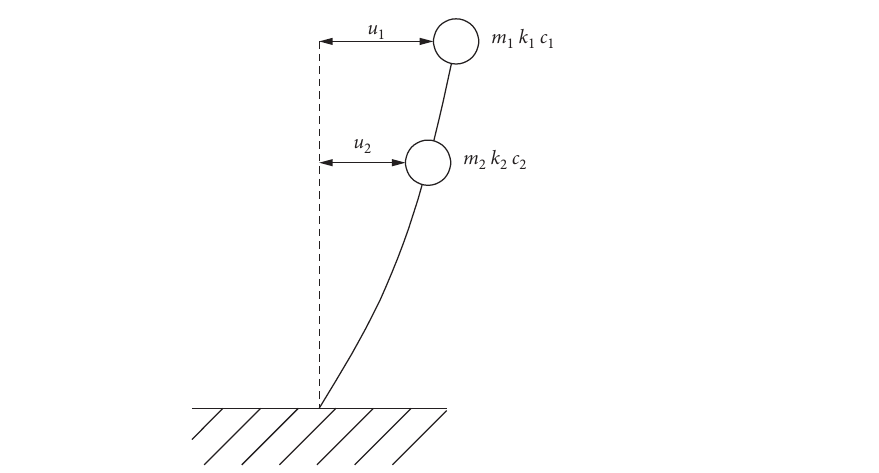
Figure 3: A two-degree-of-freedom system of the continuous beam bridge with 2 FPBs, showing corresponding displacements of the